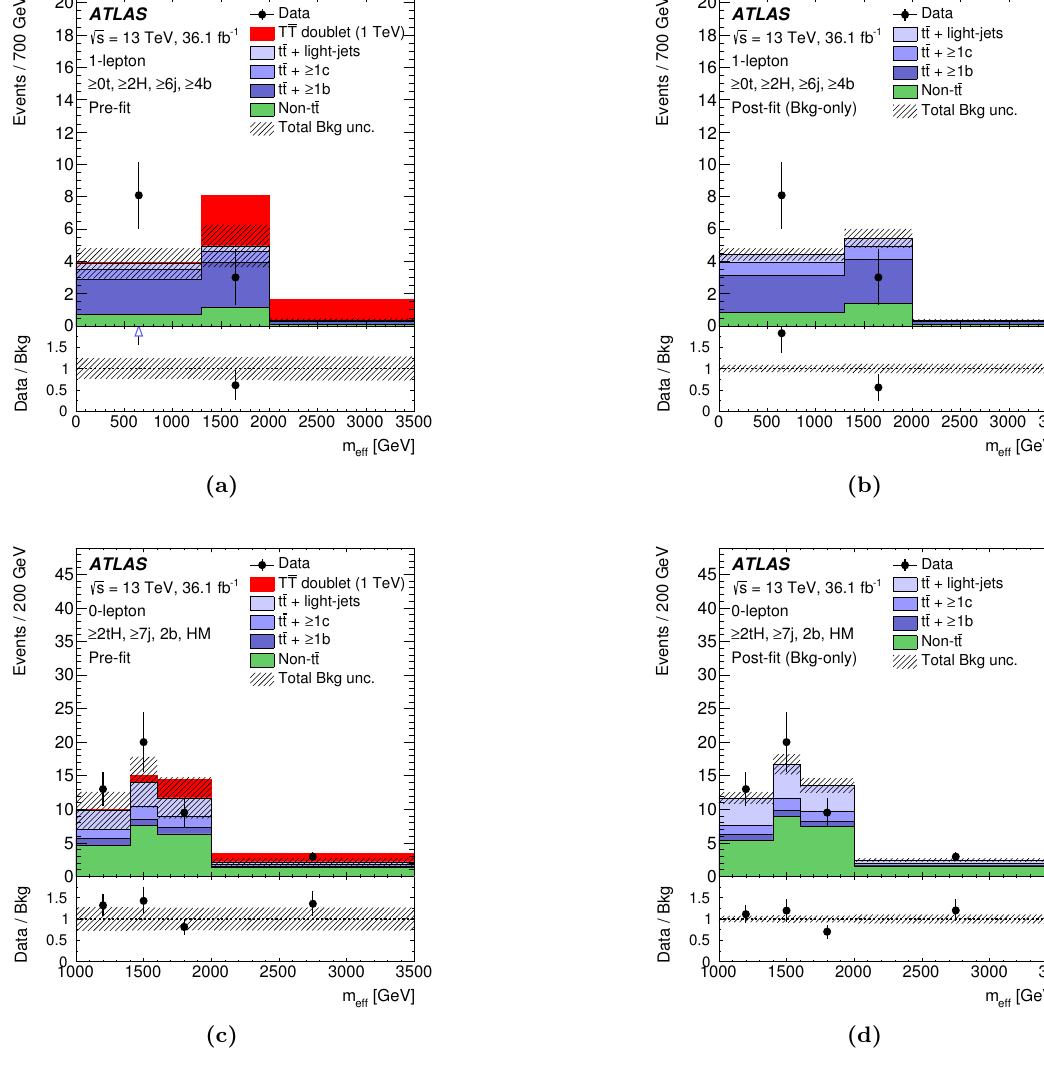
Figure 11. Comparison between the data and prediction for the m e(cid:11) distribution in some of the most sensitive search regions, before and after performing the combined (cid:12)t to data in the 0-lepton and 1-lepton channels (\Pre-(cid:12)t" and \Post-(cid:12)t", respectively) under the background-only hypothesis. Shown are the ( 2H, 6j, 4b) region in the 1-lepton channel (a) pre-(cid:12)t and (b) post-(cid:12)t, and the (cid:21) (cid:21) (cid:21) ( 2tH, 7j, 2b, HM) region in the 0-lepton channel (c) pre-(cid:12)t and (d) post-(cid:12)t. In the pre-(cid:12)t (cid:12)gures (cid:21) (cid:21) the expected T (cid:22) T signal (solid red) corresponding to m T = 1 TeV in the T doublet scenario is also shown, added on top of the background prediction. The small contributions from t (cid:22) tV , t (cid:22) tH , single top, W=Z +jets, diboson, and multijet backgrounds are combined into a single background source referred to as \Non- t (cid:22) t ". The last bin in all (cid:12)gures contains the over(cid:13)ow. The bottom panels display the ratios of data to the total background prediction (\Bkg"). The blue triangles indicate points that are outside the vertical range of the (cid:12)gure. The hashed area represents the total uncertainty of the background. In the case of the pre-(cid:12)t background uncertainty, the normalisation uncertainty of the t (cid:22) t + 1 b background is not (cid:21)